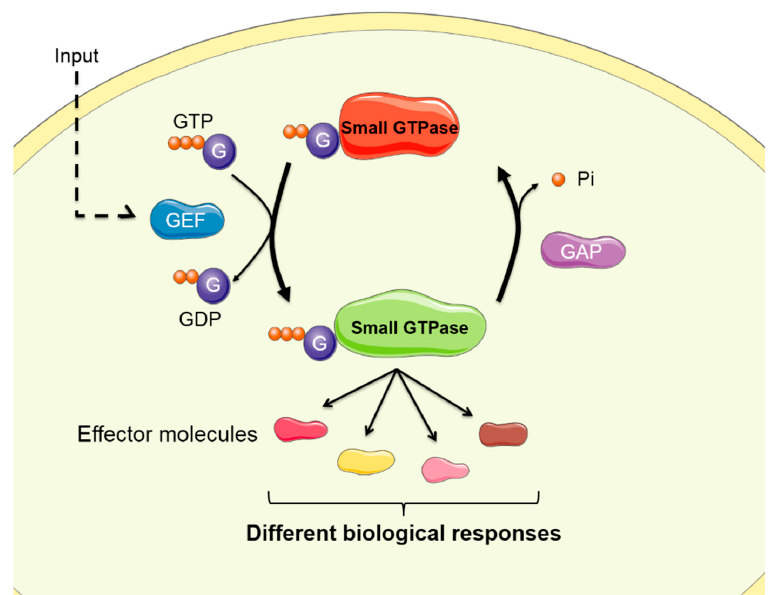
Figure 1. Activation/deactivation cycle of small guanosine triphosphatases (GTPases). The input receiving cells mediate GEF activation, facilitating the transition from the inactive configuration (guanosine-5 ′ -diphosphate (GDP)-loaded, in red) to the active configuration (GTP-loaded, in green). In the active form, small GTPases interact with effector molecules in order to transduce signals that generate different cellular responses. On the other hand, GAPs promote the hydrolysis of GTP and the consequent inactivation of the GTPase. GEF: guanine nucleotide exchange factor. GAP: GTPase activating protein.